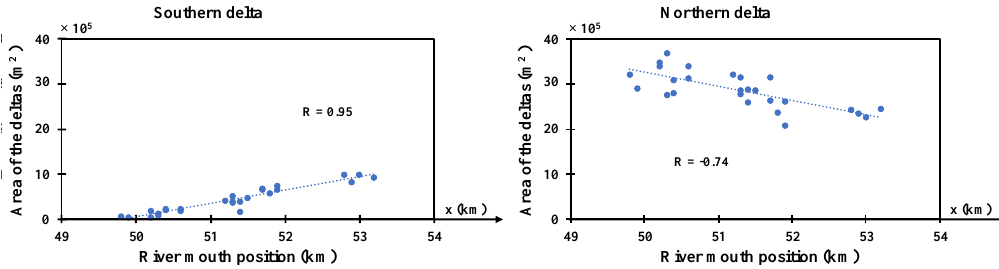
Figure 13. Relations between area of deltas and position of river mouth; ( left ) southern delta; ( right ) northern delta.